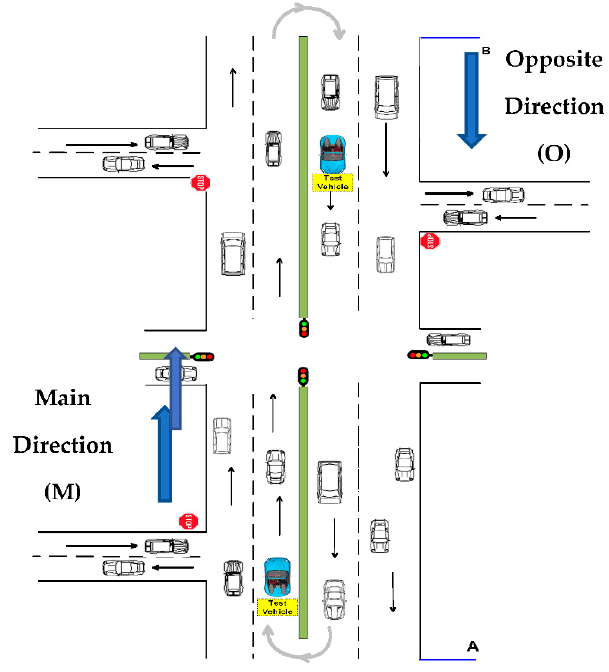
Figure 3. Schematic presentation for the main concept used in MOM.